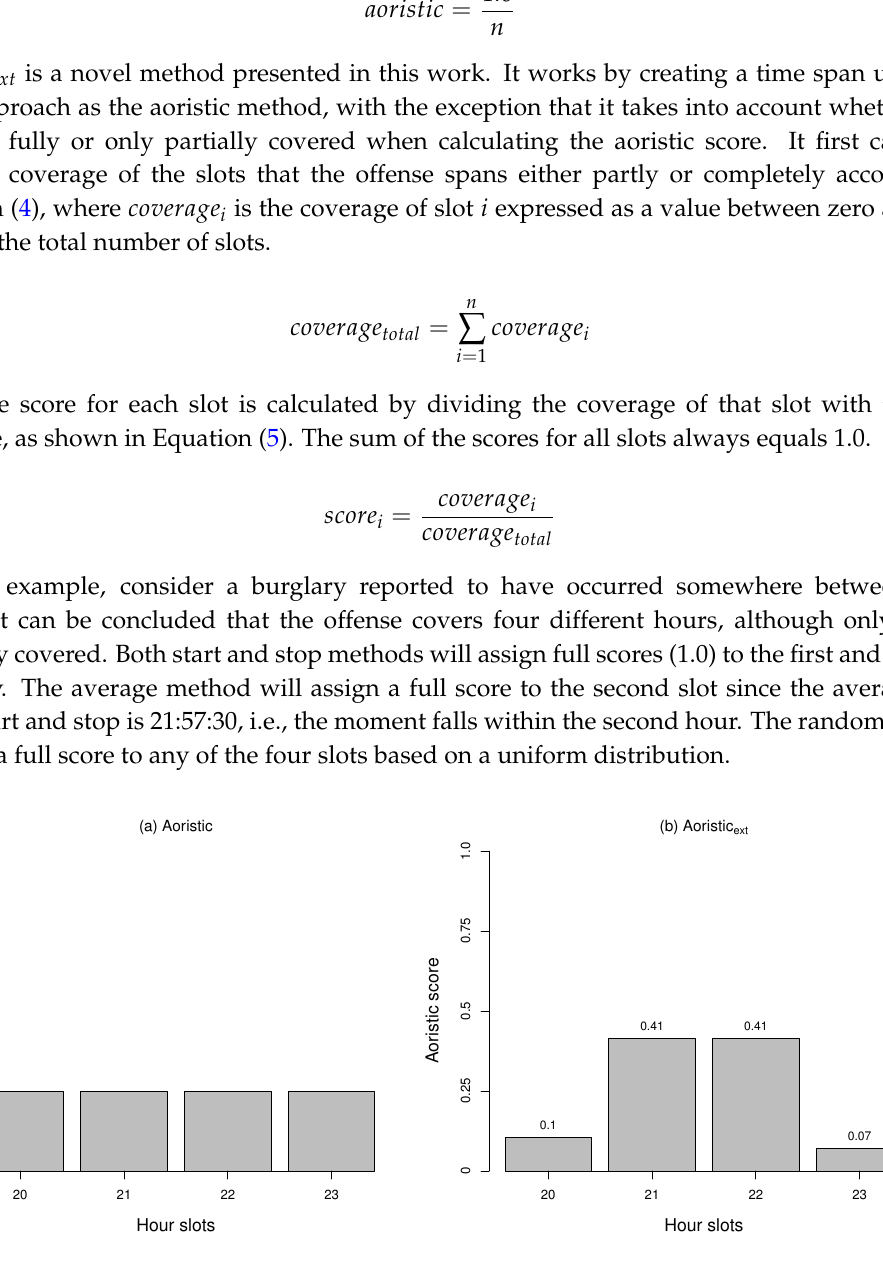
Figure 1. ( a ) The aoristic score for an example offense spanning four hours according to the time span of 20:45–23:10; ( b ) The aoristic ext scores for the same